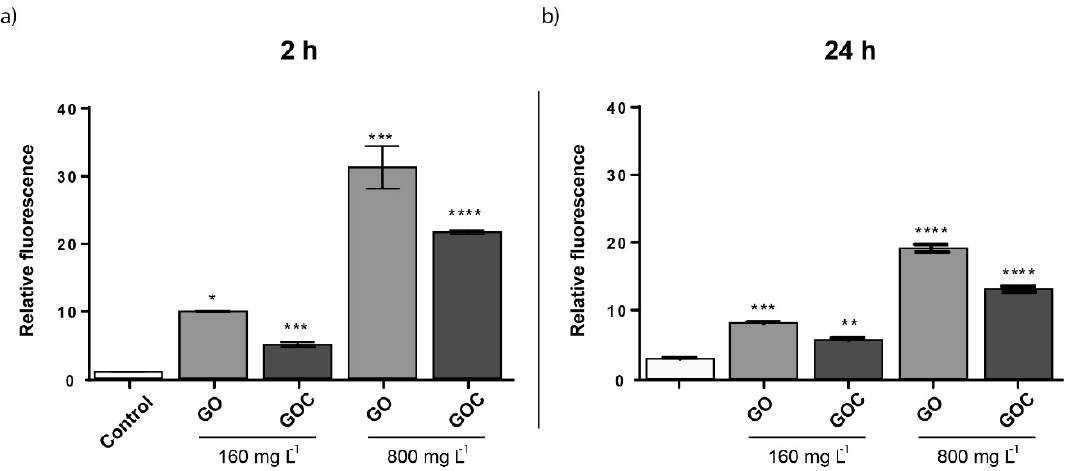
Figure 8. Oxidative stress (ROS) determination of S. cerevisiae cells exposed to 160 mg L − 1 of GO and GOC during 2 h. The reported values are expressed in arbitrary units and correspond to the averages of two biological replicates per culture condition. Differences were established using a one-way ANOVA followed by Dunnett post hoc test to compare every mean with the control, and considered significant at p ≤ 0.05. * p ≤ 0.05, ** p ≤ 0.01, *** p ≤ 0.001, **** p ≤ 0.0001.